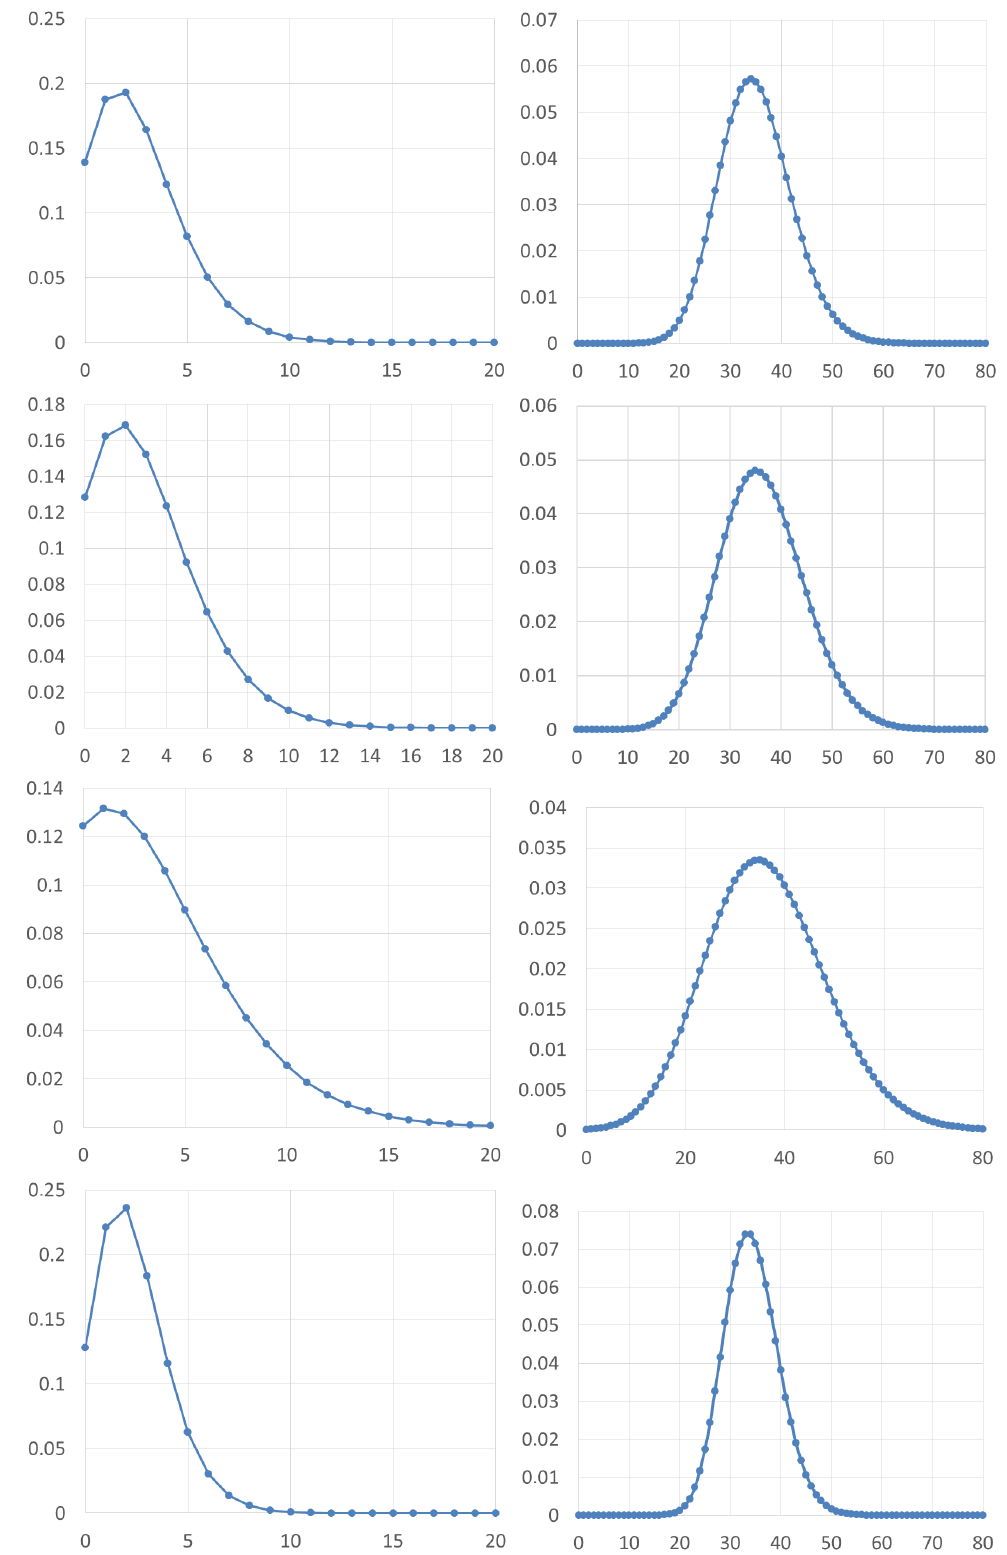
Figure 1. Discrete approximation for the probability distribution P ( i ) of the number of calls in orbit, σ = 1 ( left ) and σ = 0.1 ( right ). From top to bottom exponential ( CV = 1), gamma ( CV = √ hyperexponential ( CV = 5.5), and deterministic ( CV =